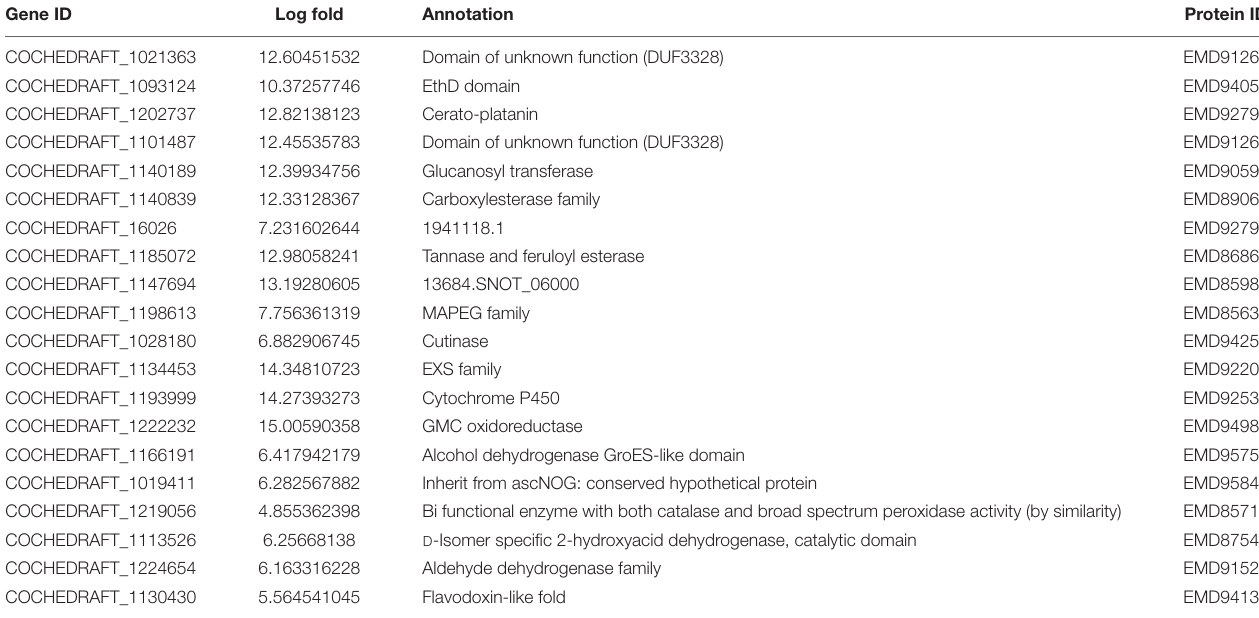
FIGURE 2 | qRT-PCR validation of the relative expression data of genes obtained in RNA-seq analysis. Expression levels of selected transcripts are shown in dark blue (qRT-PCR) and orange (RNA-seq). The fungal actin gene was used for transcript normalization of the signal intensity which is shown on the y axis. The x axis shows comparisons of the results of the two analyses. Error bars show standard deviations for triplicate assays. TABLE 2 | Top 20 highly upregulated genes of B. maydis differentially expressed in inoculated resistant and susceptible